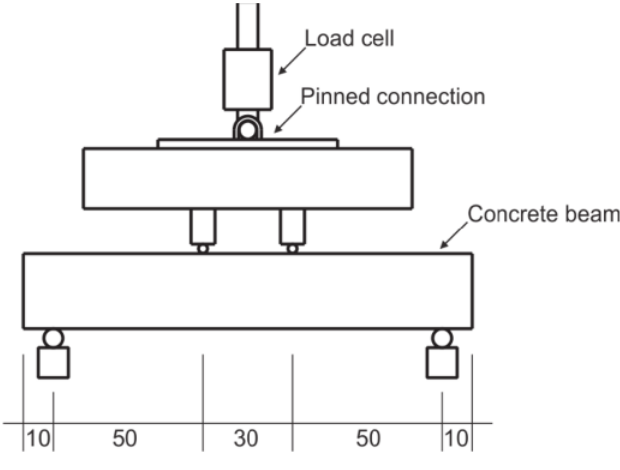
Figure 1 Four-point bending test set-up (dimensions in